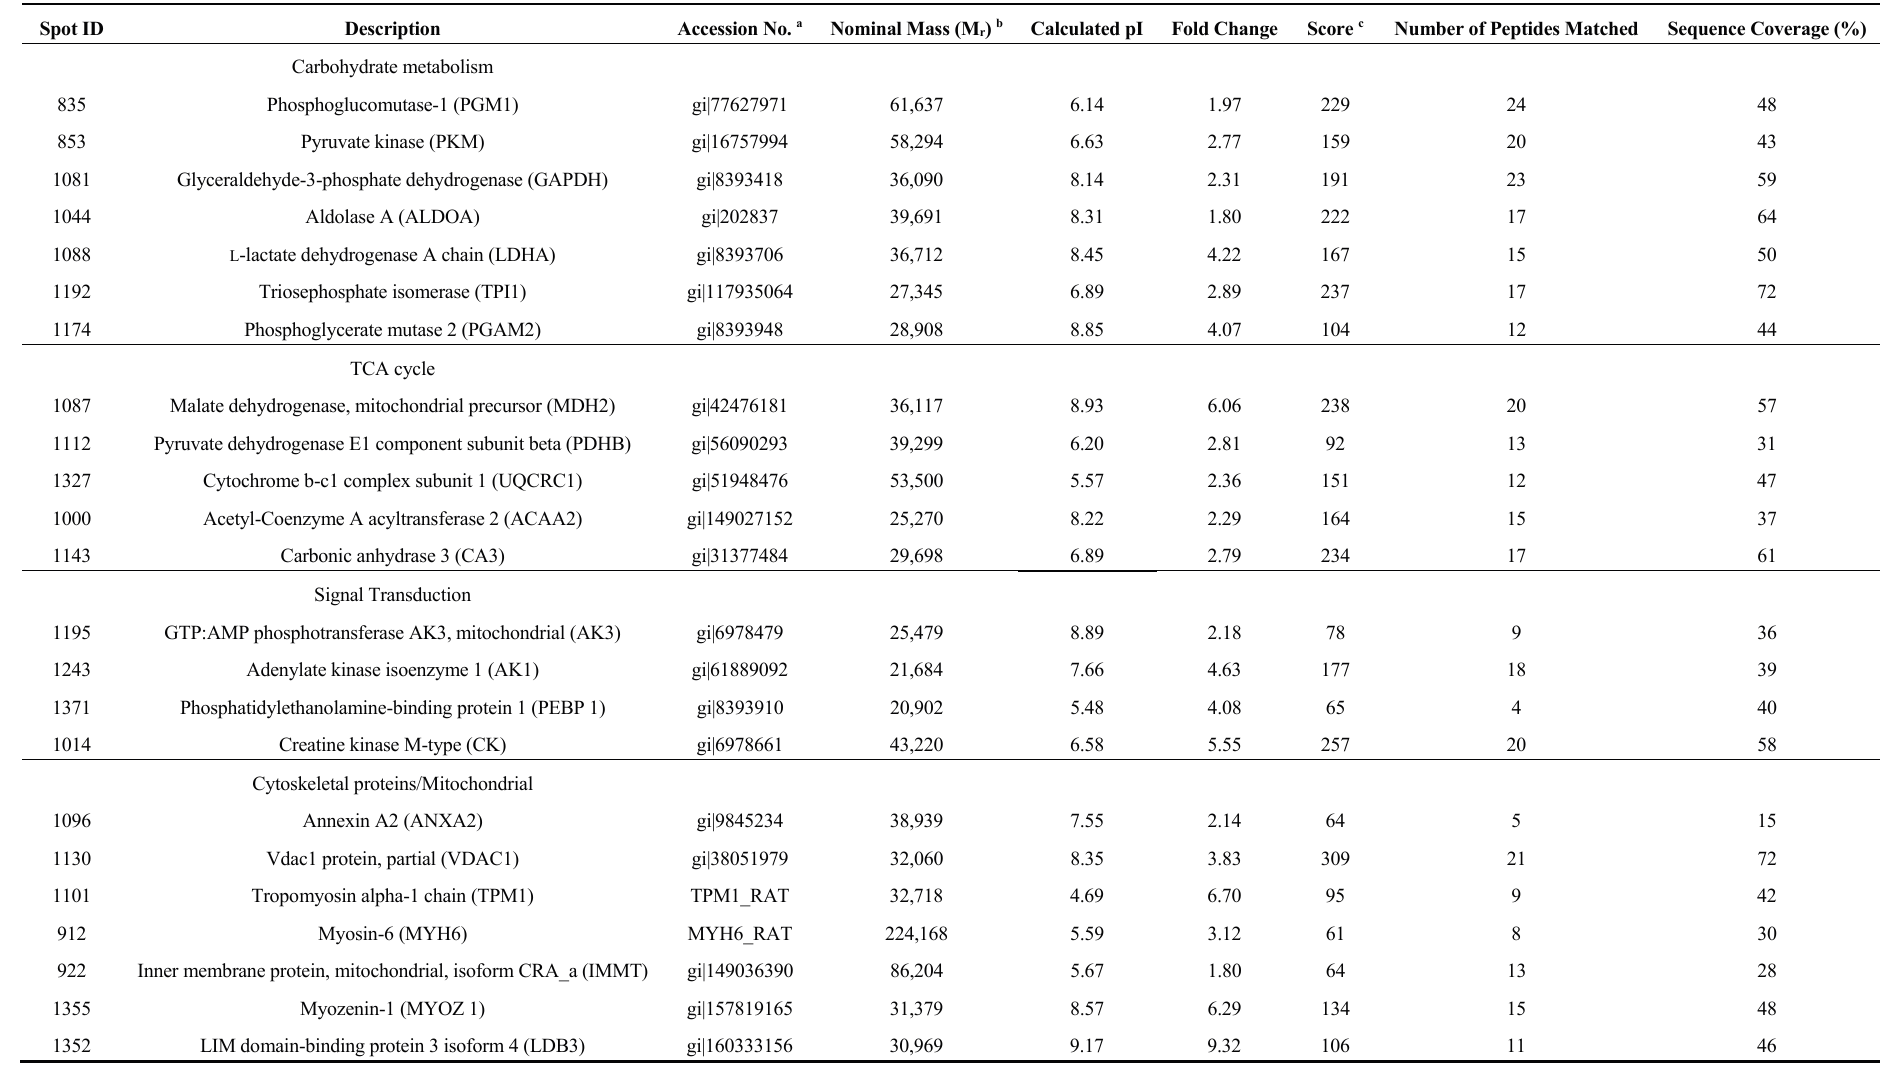
Table 1. List of proteins showing differential expression between control and thiodigalactoside (TDG)-treated